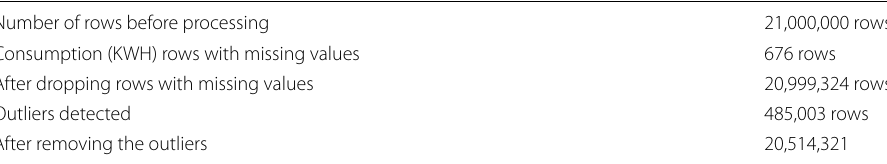
Table 3 Effect of data cleaning on the dataset Number of rows before processing 21,000,000 rows Consumption (KWH) rows with missing values 676 rows After dropping rows with missing values Outliers